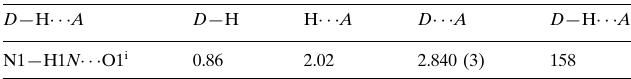
Hydrogen-bond geometry (A˚ , (cid:1)